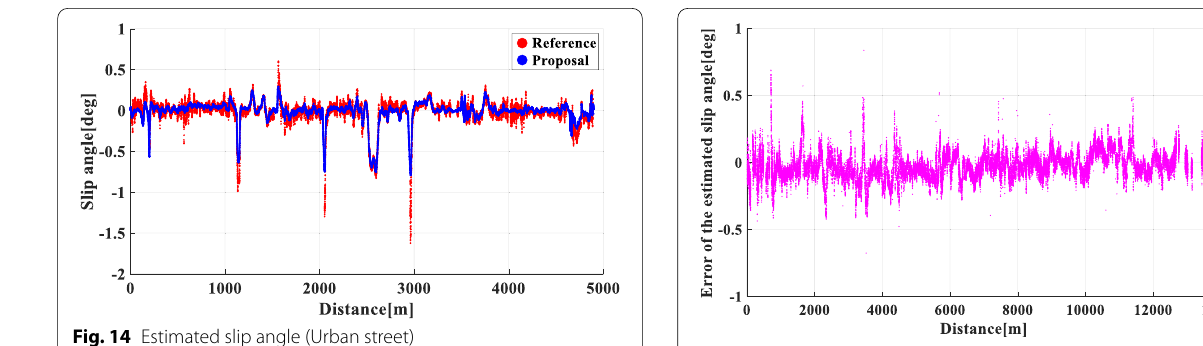
Fig. 17 Error of estimated slip angle (Urban highway)